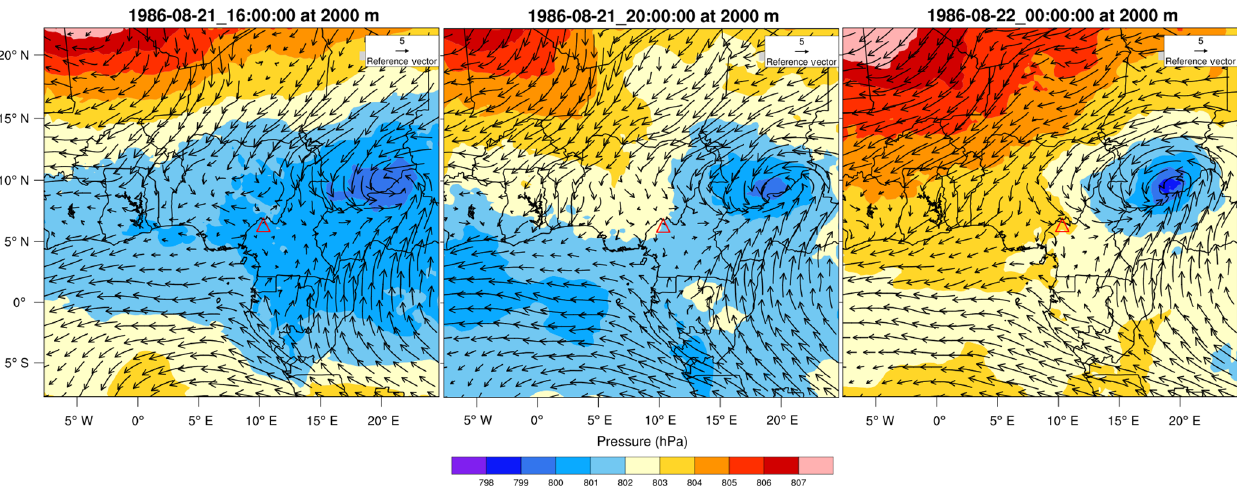
Figure 6. Synoptic meteorological situation according to the WRF-ARW simulation showing pressure contours (hPa) and wind vectors (ms − 1 ) for domain d02 (first nest, 27km resolution domain) at 2000m height above sea level. Results for 21 August 1986 at 16:00 (left), 20:00 (centre), and 24:00 (right) UTC. The red triangle shows the location of the Nyos Lake. For clarity, only a few model wind vectors are